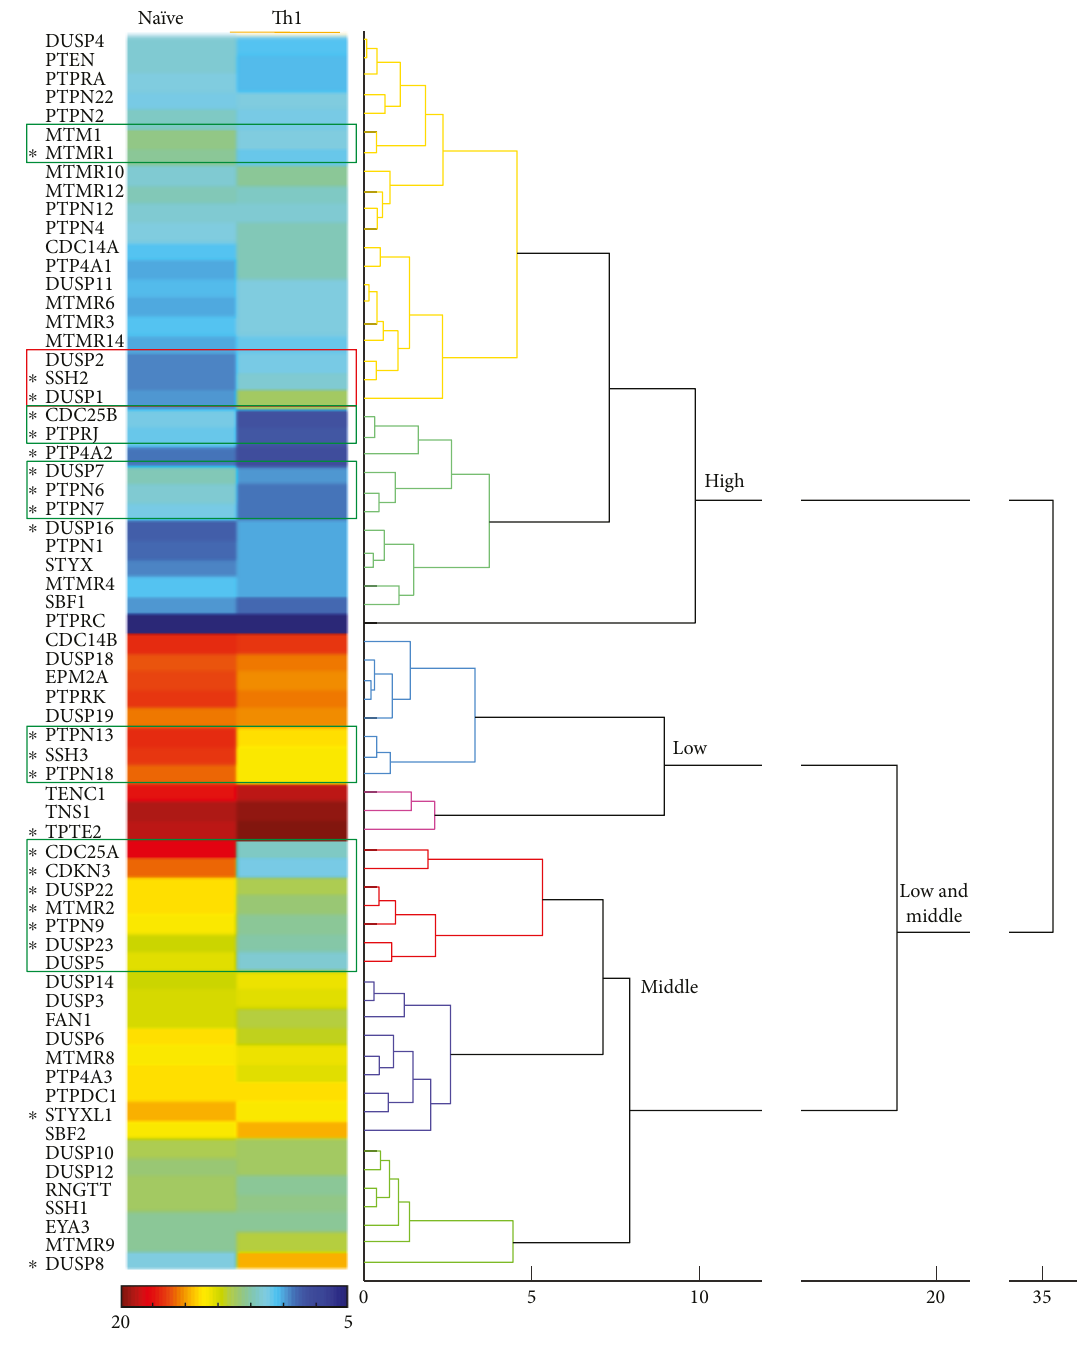
Figure 2: Agglomerative hierarchical tree of the gene expression patterns in naïve and Th1 cells. Numbers below the tree indicate the distance among gene patterns. Heat map represents the average DCT obtained for each gene in both conditions and 3 donors. The calibration bar is shown between 5 and 20 DCTs. Green and red squares point to clusters of upregulated and downregulated genes, respectively. Asterisks indicate those genes whose expression levels were considered to signi fi cantly change, as detailed in Table 2, and explained in Materials and Methods. Clusters are indicated of high, middle, and low